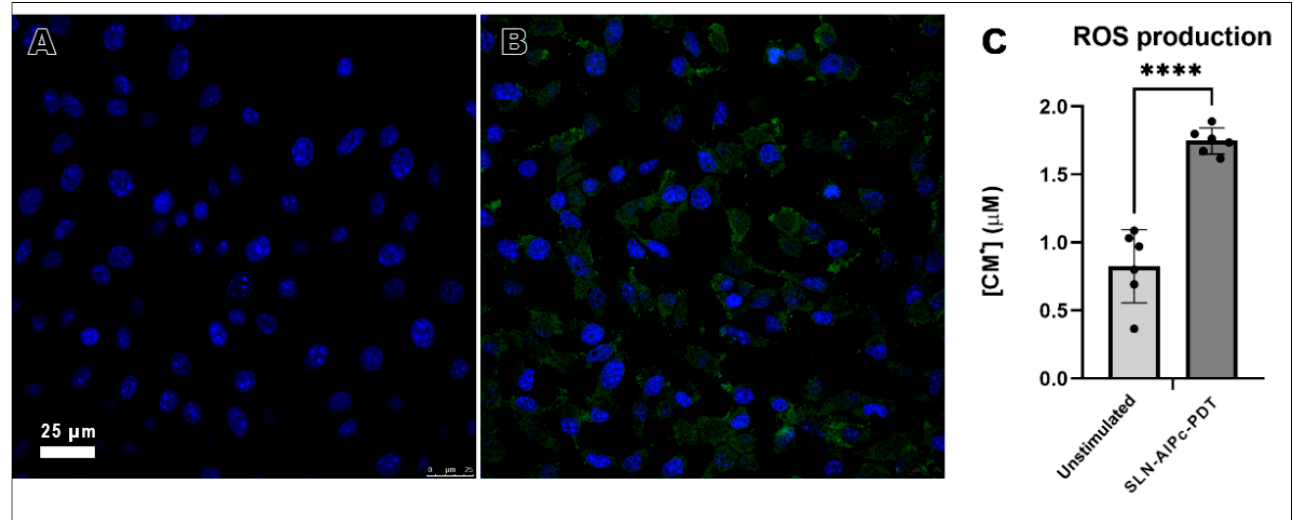
Figure 14. ROS production in B16-F10 cells treated with SLN-AlPc. Images were taken in confocal microscopy ( A , B ) and paramagnetic resonance ( C ). ( A ) B16-F10 cells that were not irradiated had no ROS production (green) since only the nucleus (blue) could be seen in the image. ( B ) ROS production was observed after B16-F10 irradiation. ( C ) Quantification of ROS production in different treatment conditions. **** p < 0.0001 compared to control.